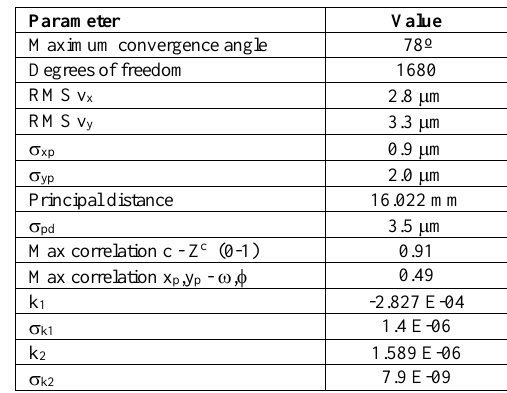
Table 1. Pertinent results from self-calibrating bundle